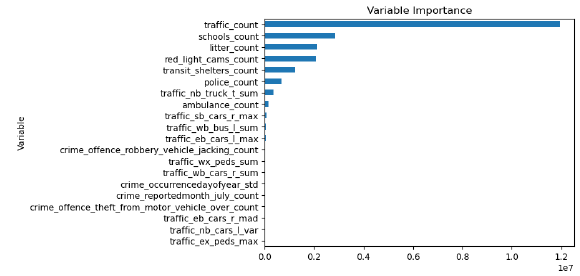
Figure 3 . Top 20 important variables across models.